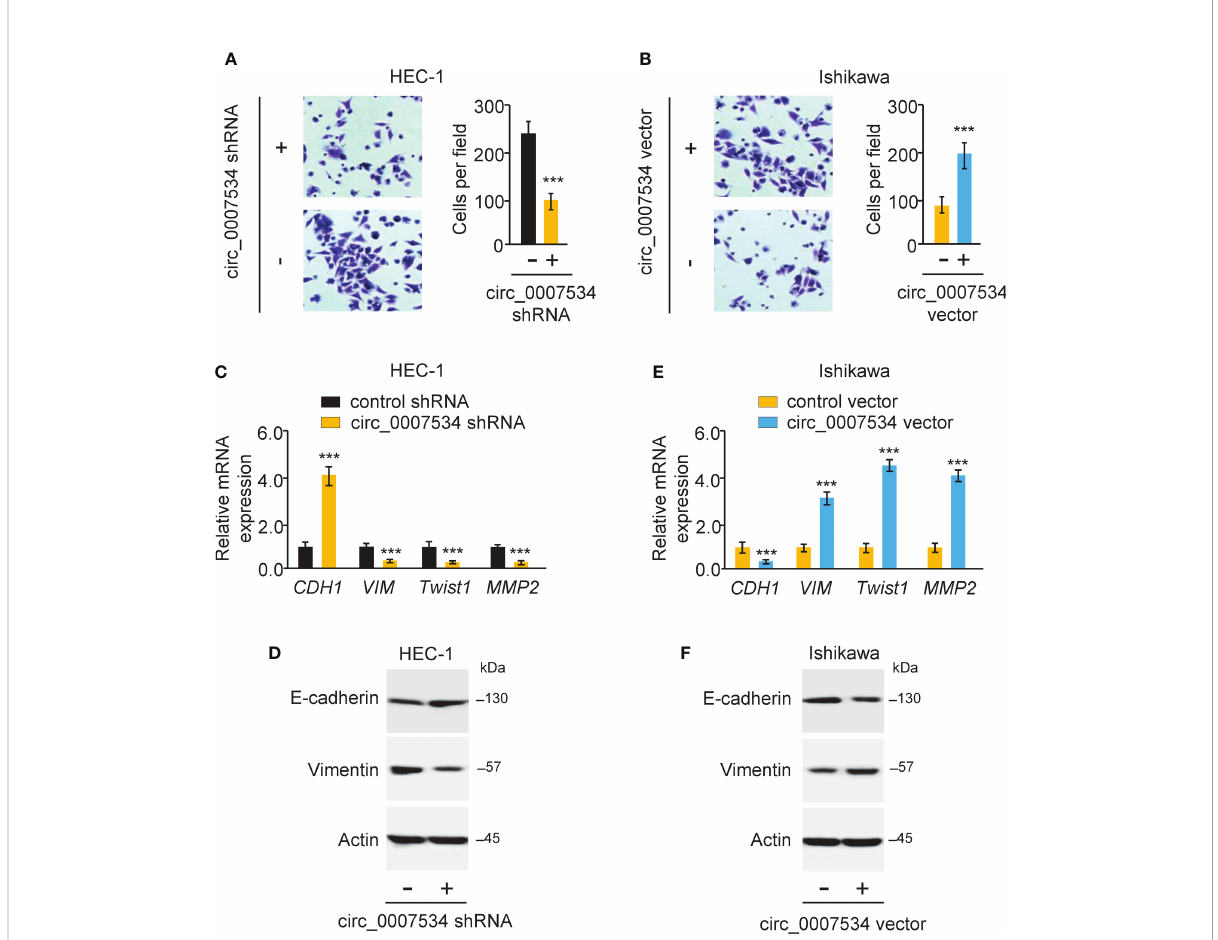
FIGURE 3 Circ_0007534 promotes invasion and EMT in endometrial cancer cells. (A, B) The invasion abilities of HEC-1 cells after silencing circ_0007534 (A) or Ishikawa cells after overexpression of circ_0007534 (B) were measured with an invasion assay. (C, D) The mRNA (C) and protein (D) expression of the indicated genes in HEC-1 cells was measured after silencing circ_0007534. (E, F) The mRNA (E) and protein (F) expression of the indicated genes in Ishikawa cells was examined after overexpression of circ_0007534. *** P <